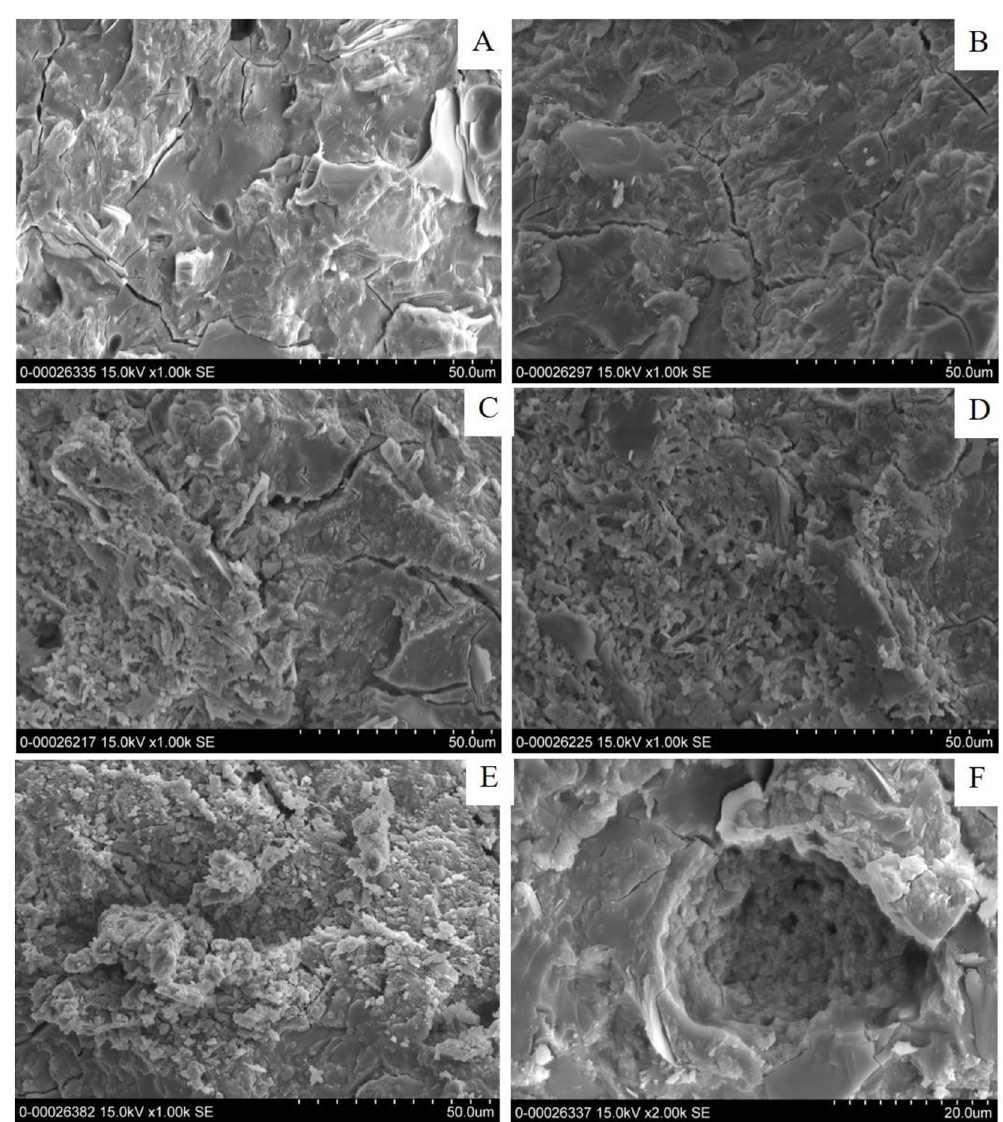
Fig 5. FE-SEM photomicrographs of MK-based geopolymer containing different amounts of zeolite (A) 0%, (B) 10%, (C) 20%, (D) 30%, (E) and (F) 40 wt%. respectively. These ratios are largely deviated from the SiO /Al O molar ratio of the starting 2 2 3 material (2.25) used for geopolymer preparation. This implied that not all aluminum phases played a role in the development of the geopolymeric structure. In other words, the silicate phase from starting mix was more soluble than the aluminate phases. Therefore, the obtained geopolymeric gel contained a higher SiO /Al O ratio than the starting mix. The SiO /Al O 2 2 3 2 2 3 molar ratios of the crystalline phases at position B and D for the 40 wt% Z and TZ geopolymers after polymerization were 2.40 and 2.88, respectively. These ratios are slightly different from the SiO /Al O molar ratio of the starting zeolitic materials (3.0–3.2). Moreover, Ti peaks were 2 2 3 observed in both areas of the geopolymeric structure and crystalline particles. The SiO /Al O 2 2 3 molar ratio of the geopolymeric structure obtained by EDS was higher than that of starting